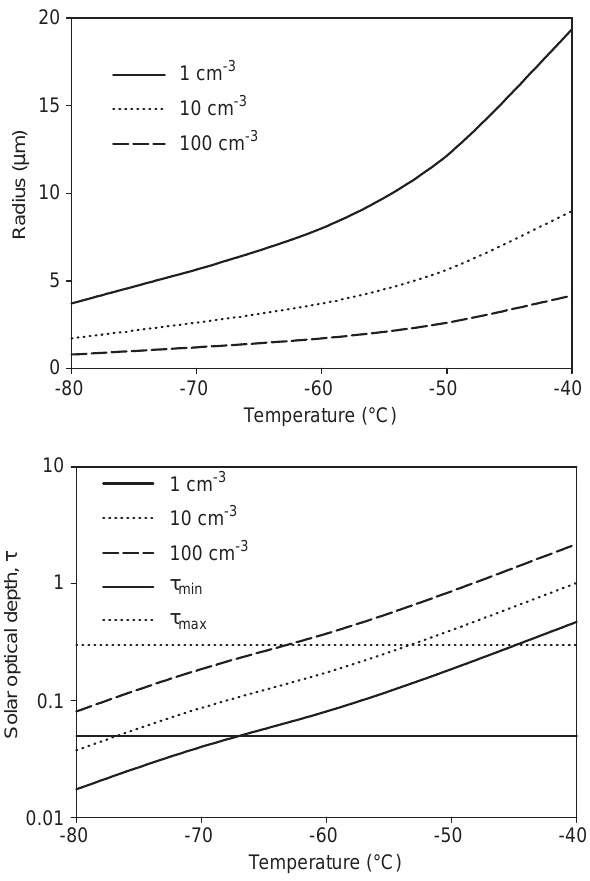
Fig. 2a, b. Particle radius and solar optical depth s versus temper- ature for a 200 m thick contrail for three values of particle number concentration of monodisperse particles. IWC as given by the solid curve of Fig. 1, and extinction e(cid:129)ciency of 2. The two horizontal lines in the lower panel denote the range of data (cid:133) s (cid:136) 0 : 05 to 0.3) obtained by Ja¨ ger et